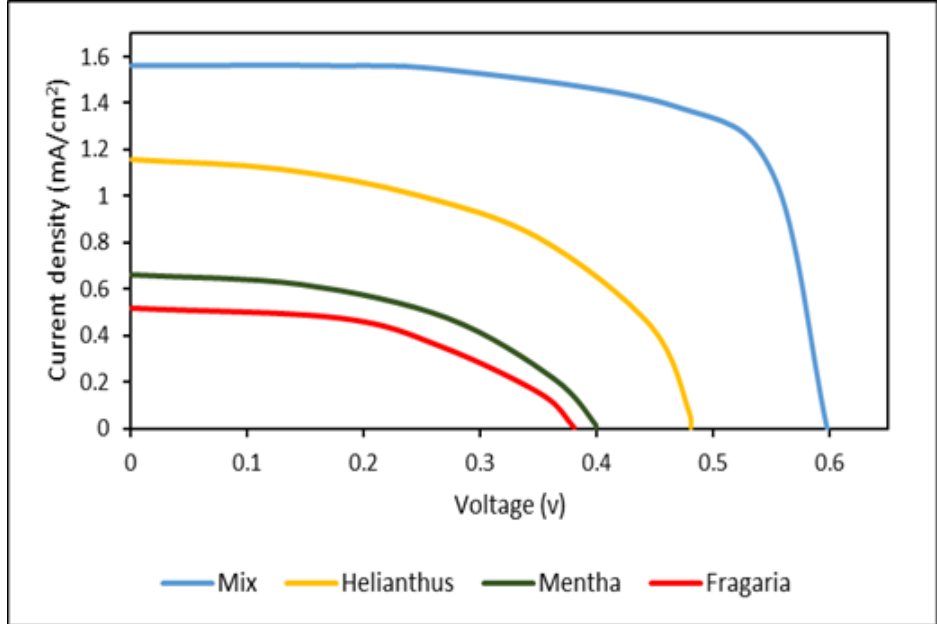
Figure 13. J – V curve for the dyed